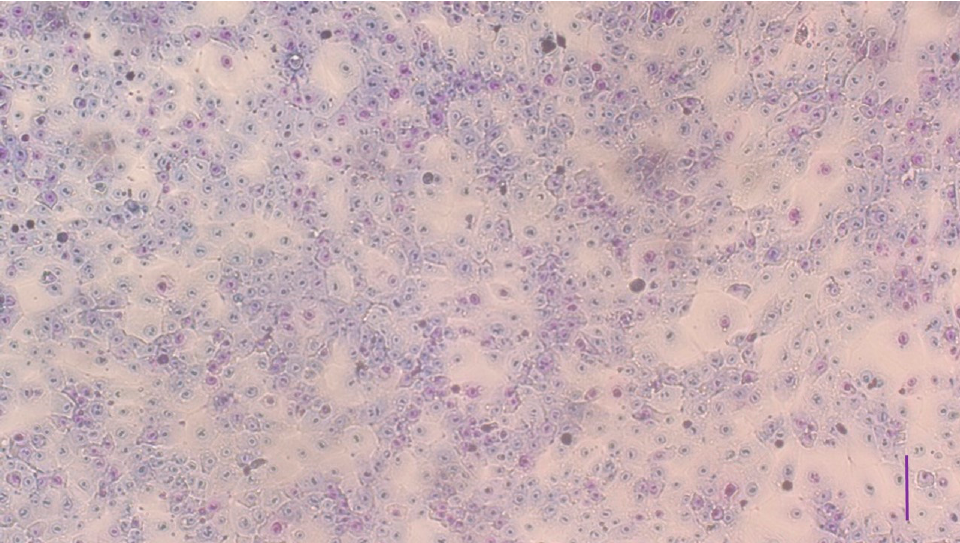
Figure 2. Confluent uroepithelial cell culture on day 6 after plating stained by Giemsa (bar = 100 µ m). One day after plating, all the cells showed pan-ytokeratin positivity with eFluor labeled anti-pan-cytokeratin antibody, but no uroplakin III positivity was detected with FITC labeled antibody (Figure 3). In the case of 6-day old cultures, all the cells showed pan-cytokeratin positivity, and the majority of the cells showed uroplakin III positivity as well (Figure